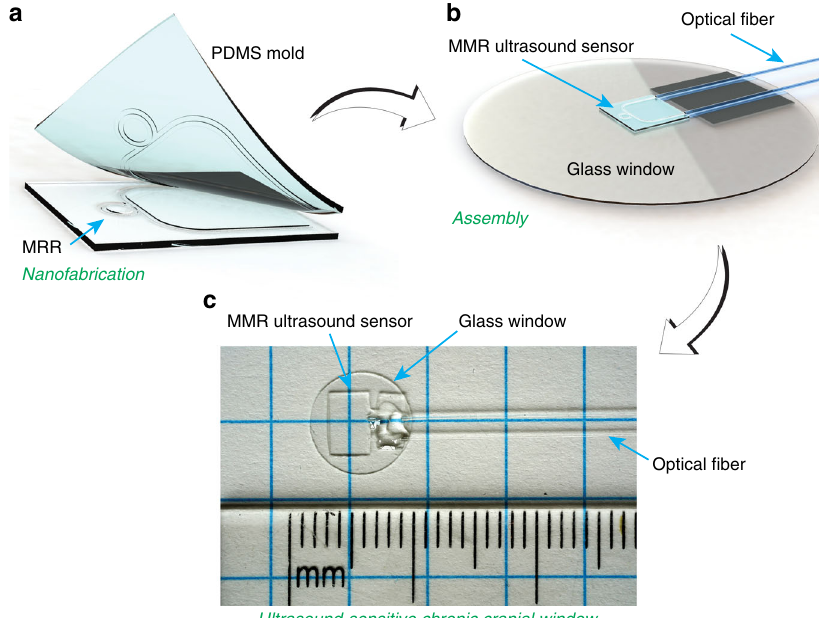
Fig. 1 Process to fabricate usCCW: ( a ) Nanofabrication of MRR on transparent substrate using sNIL process; ( b ) assembling an MRR-based ultrasonic detector with matching optical fi bers, onto a circular cover slide (8 mm in diameter); and ( c ) fi nally assembled usCCW